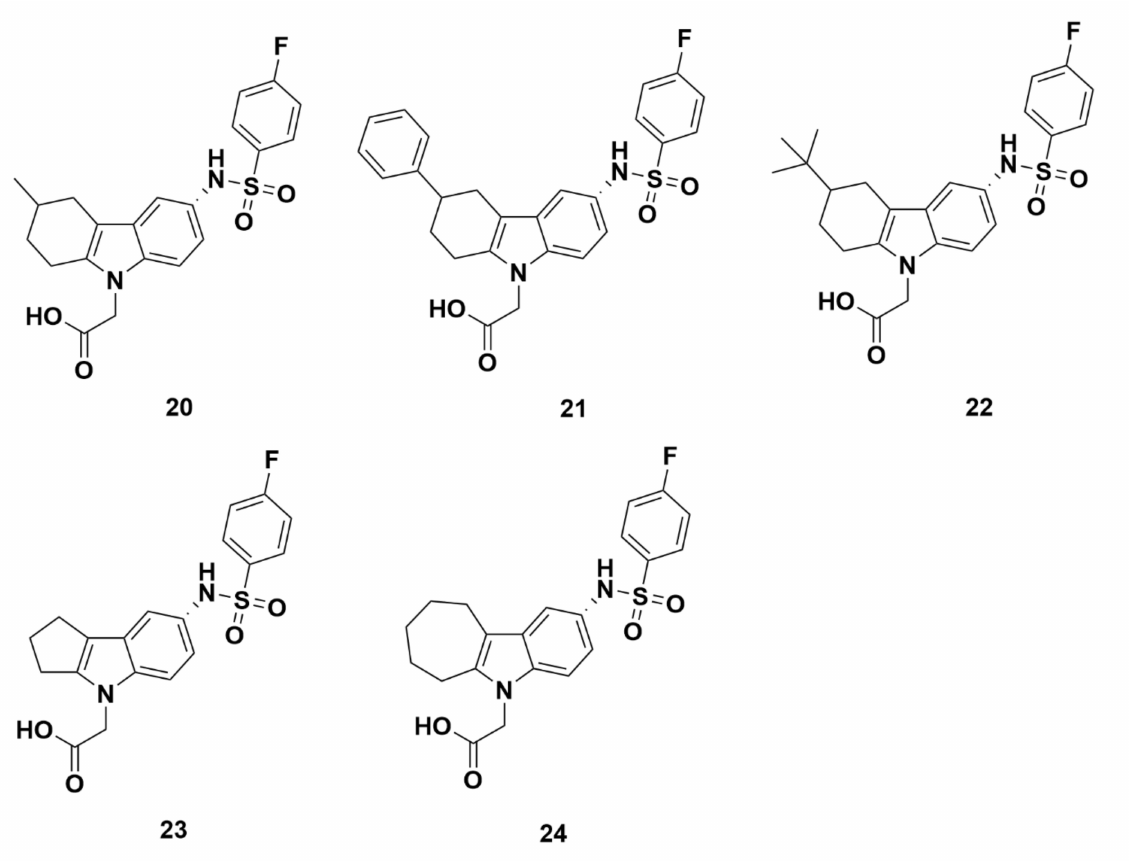
Figure 4. Molecular structures of compounds 20 – 24